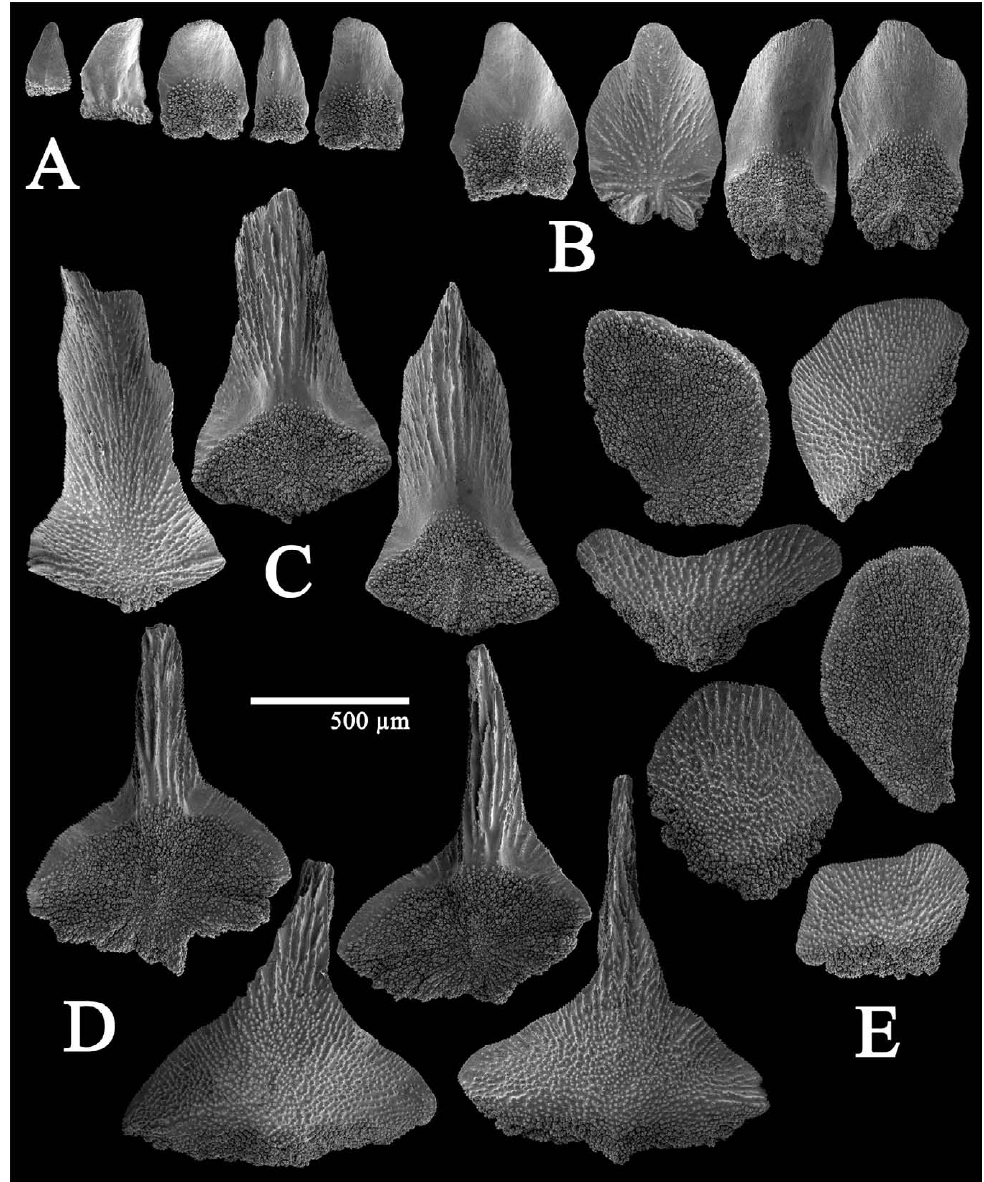
Fig . 12. – Thouarella andeep n. sp., holotype ZiZMH c11744: accessory opercular scales (a). opercular scales from inner (b) and outer (c) alternate cycle. Marginal scales (d). body scales